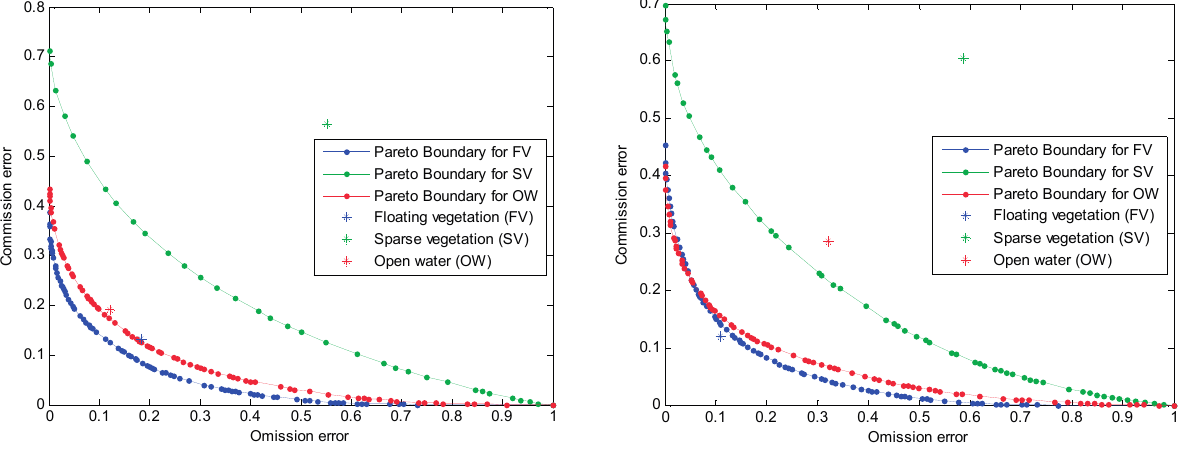
Figure 7. An analysis of the trade-off between commission and omission errors in the classification of floating vegetation (FV), sparse vegetation (SV) and open water (OW) by NDVI slicing for image pair 1 ( left ) and image pair 2 ( right ). Pareto Boundaries show the optimal classifications that can be achieved with low resolution MERIS data using reference obtained with higher resolution ETM+. Positions of the omission and commission errors in the classification of FV, SV and OW are shown in the error space.